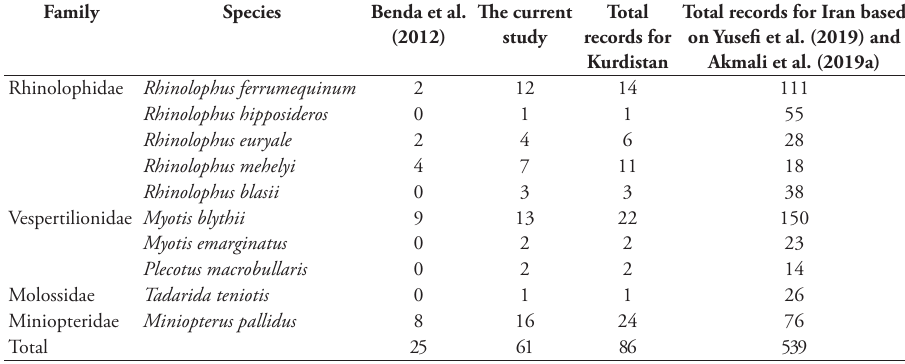
The current Total Total records for Iran based (2012) study records for on Yusefi et al. (2019) and Kurdistan Akmali et al. (2019a)